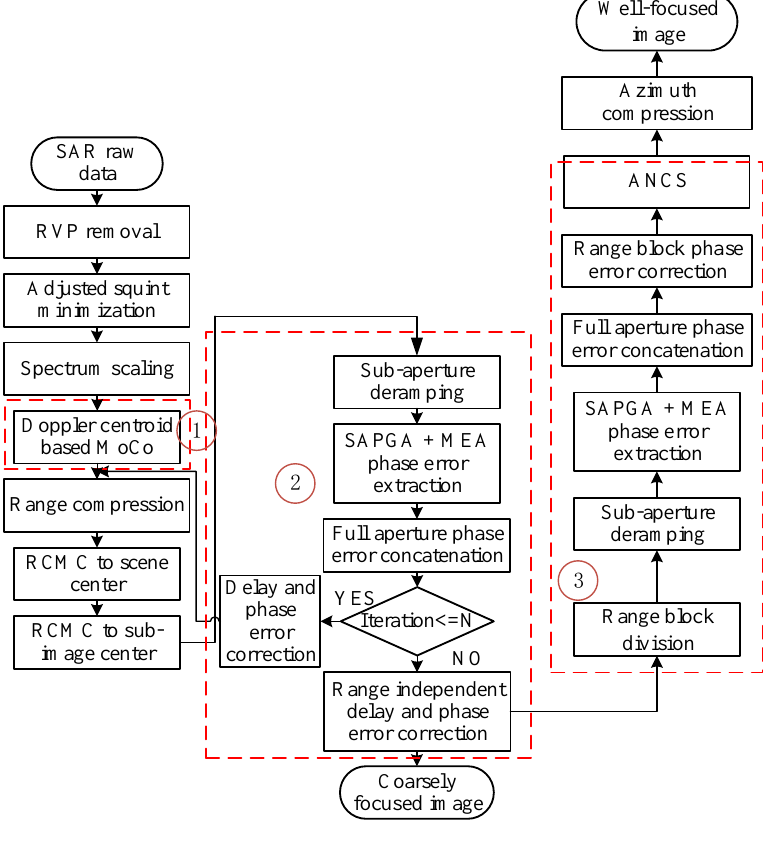
Figure 2. Flowchart of the proposed MoCo